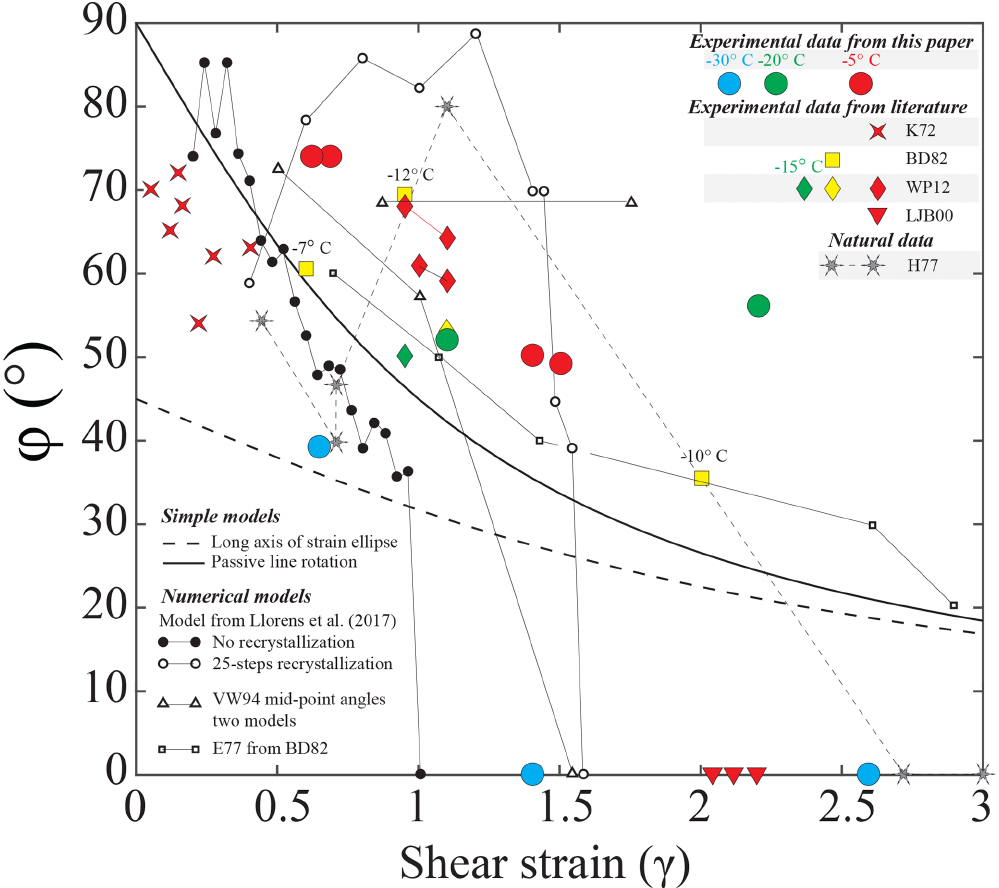
Figure 8. Plots of the angle between c -axis clusters, ϕ , for experiments from this study, experiments from the literature, data from natural shear zones, results of simple models and results of numerical models. Experimental data are as follows: K72: Kamb (1972); BD82: Bouchez and Duval (1982); LJB00: Li et al. (2000); WP12: Wilson and Peternell (2012). Symbol colors broadly indicate deformation temperature, and left-to-right position of symbols in the legend indicates relative temperatures. Outcomes from published numerical models are as follows: VW94: Van der Veen and Whillans (1994); E77: the Etchecopar (1977) model as applied by Bouchez and Duval (1982). Models from Llorens et al. (2017) are explained in the text and CPOs from these are illustrated in Fig. 9. Data from natural shear zones are as follows: H77: Hudleston (1977). Symbols tied by lines indicate they are from one